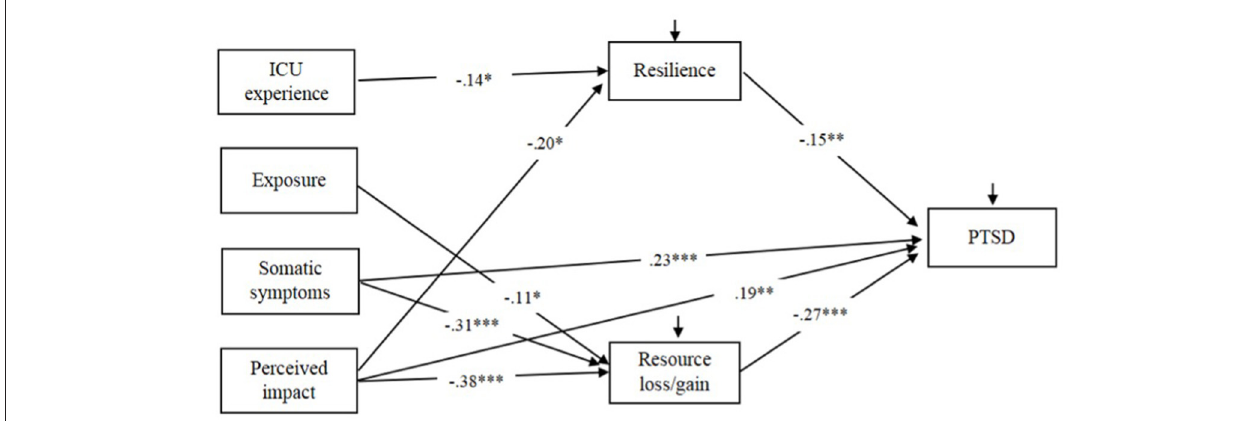
FIGURE 1 | Proposed mediation model of PTSD symptoms with standardized path coefficients. The non-significant path and covariance between resilience and resource loss/gain were not showed for simplicity reasons (* p < 0.05, ** p < 0.01, *** p <